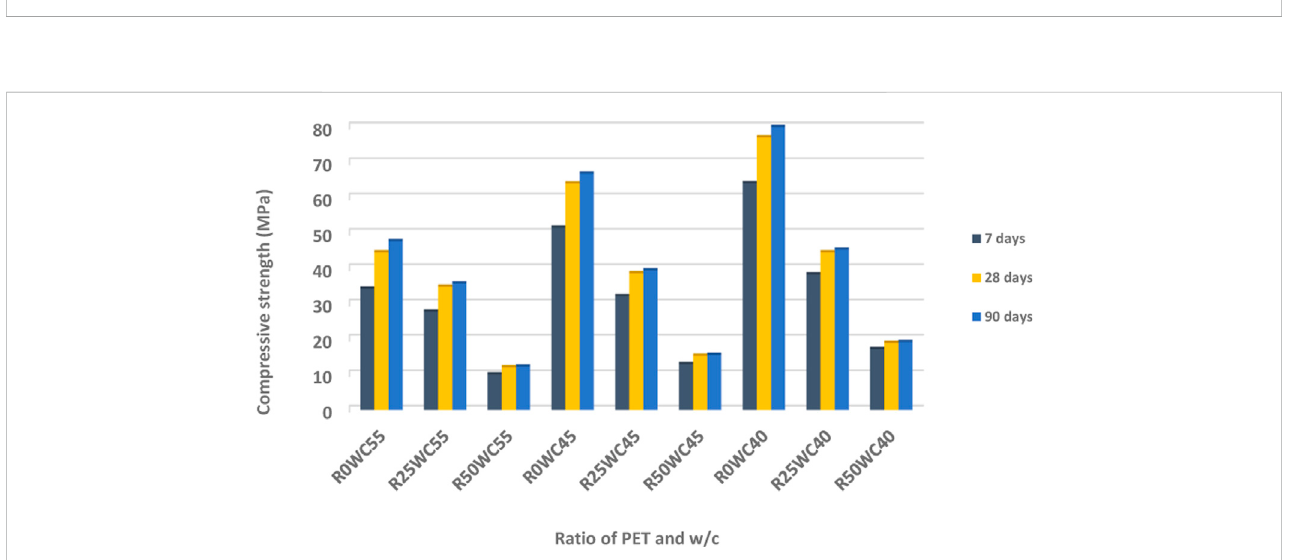
Relationship between compressive strength and thermal conductivity.